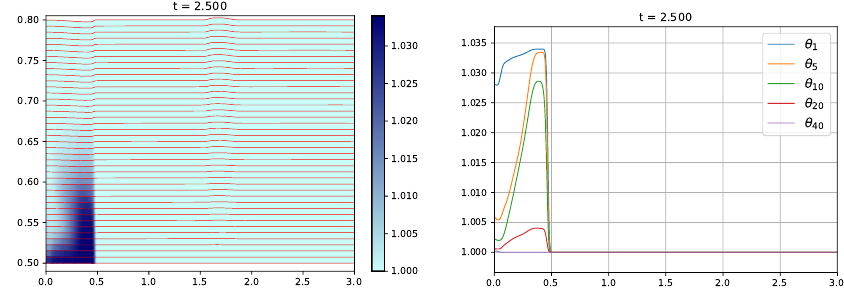
Figure 22. Evolution of the density driven current at t = 2.5